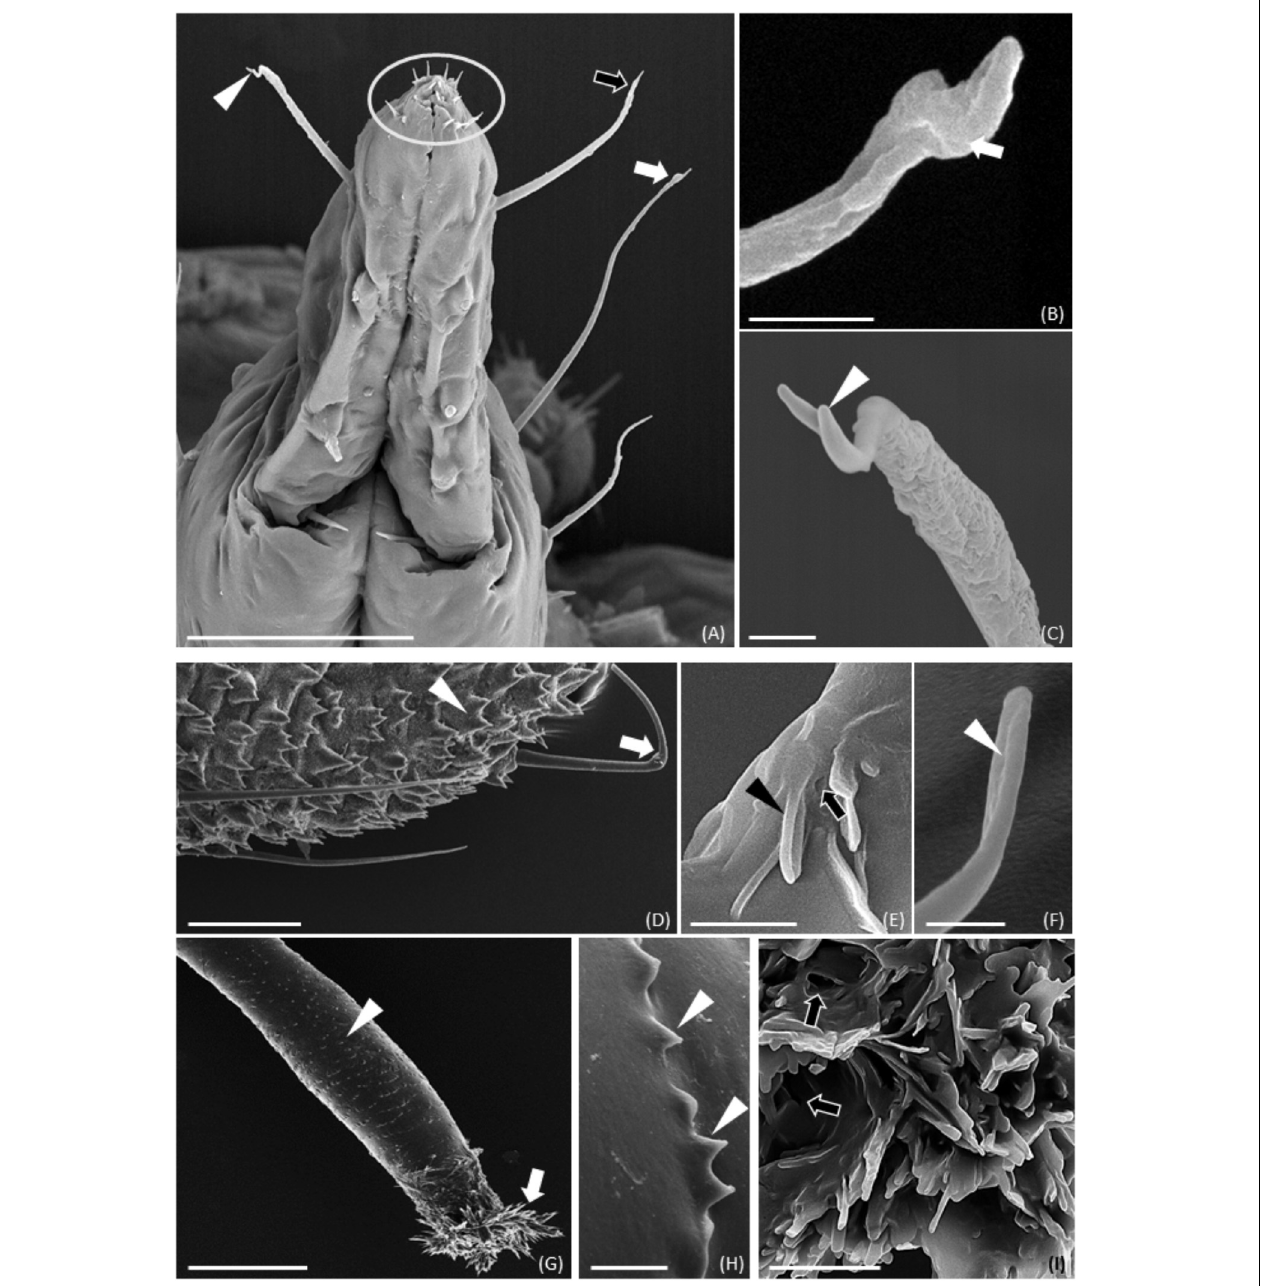
FIGURE 2 | SEM images showing sensilla on M. viciae mouthparts, cauda and cornicles. (A) Long sensilla symmetrically distributed (arrowhead) and short sensilla (encircled) situated on the labium tip. (B) Detail of long sensilla tip with pre-apical expansion (black arrow in (A) ) or in the shape of a cup (arrow in (A,B) ). (C) Detail of long sensilla branched tip (arrowhead). (D–F) Detail of porous (arrow in (E) ) or fissure like structures (arrowheads in (E,F) ) on long sensilla and finger-like extensions (arrowhead in (D) ) on M. viciae cauda. Finally, SEM observation highlights the presence of cuticular finger-like structures (arrowheads in (G,H) ) on cornicle surface. Moreover, hole-like structures are evident among cuticular tufts (arrows in (I) ) of cornicle terminal region. Bar in (A) , 50 µ m; bars in (B , E , F) , 1 µ m; bar in (C) , 2 µ m; bar in (D) , 25 µ m; bar in (G) , 100 µ m; bars in (H,I) , 5 µ